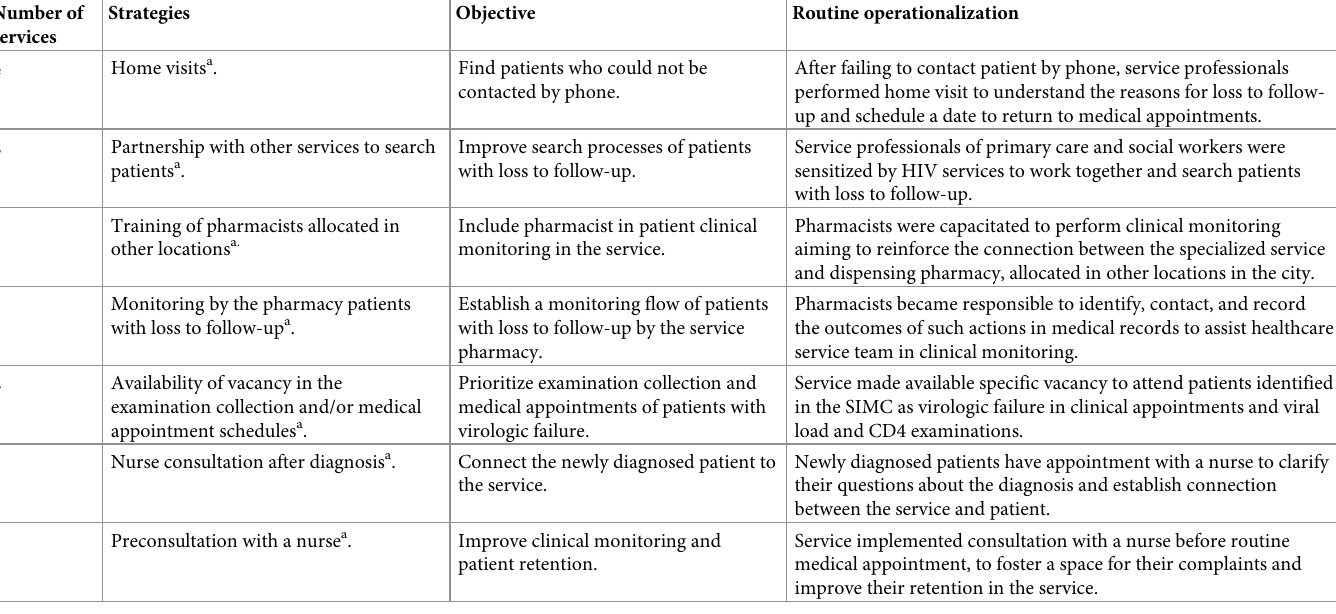
Table 6. Strategies tailored by healthcare professionals to engage PLHIV with a detectable viral load, treatment gap, and/or